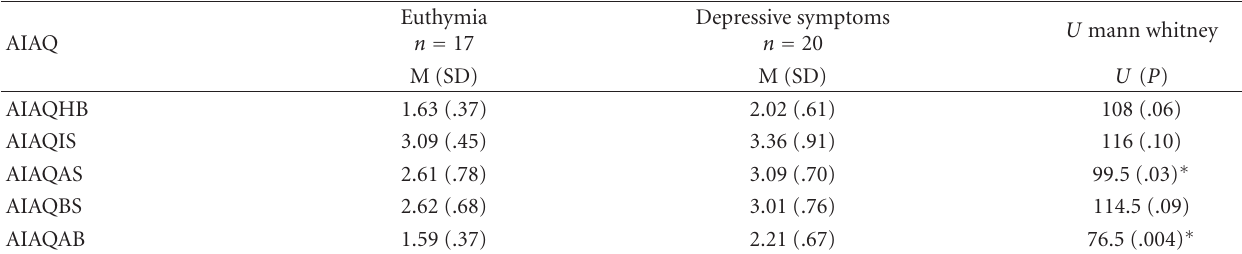
Table 3: Scores in the AIHQ subscales of the bipolar patients in state of euthymia and those with depressive symptoms. Euthymia n = AIAQ